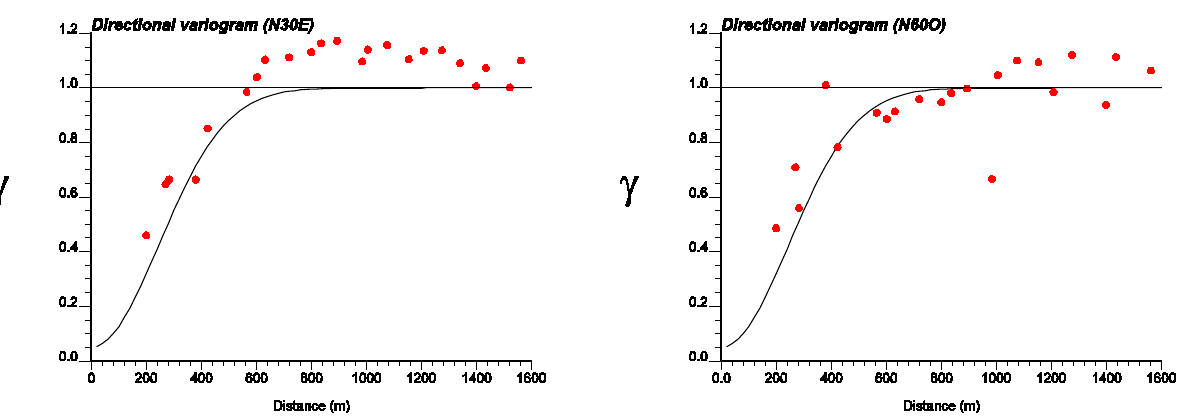
Figure 10. Directional variogram representing the maximum (left) and minimum (right) anisotropy directions of the four spatial sampling